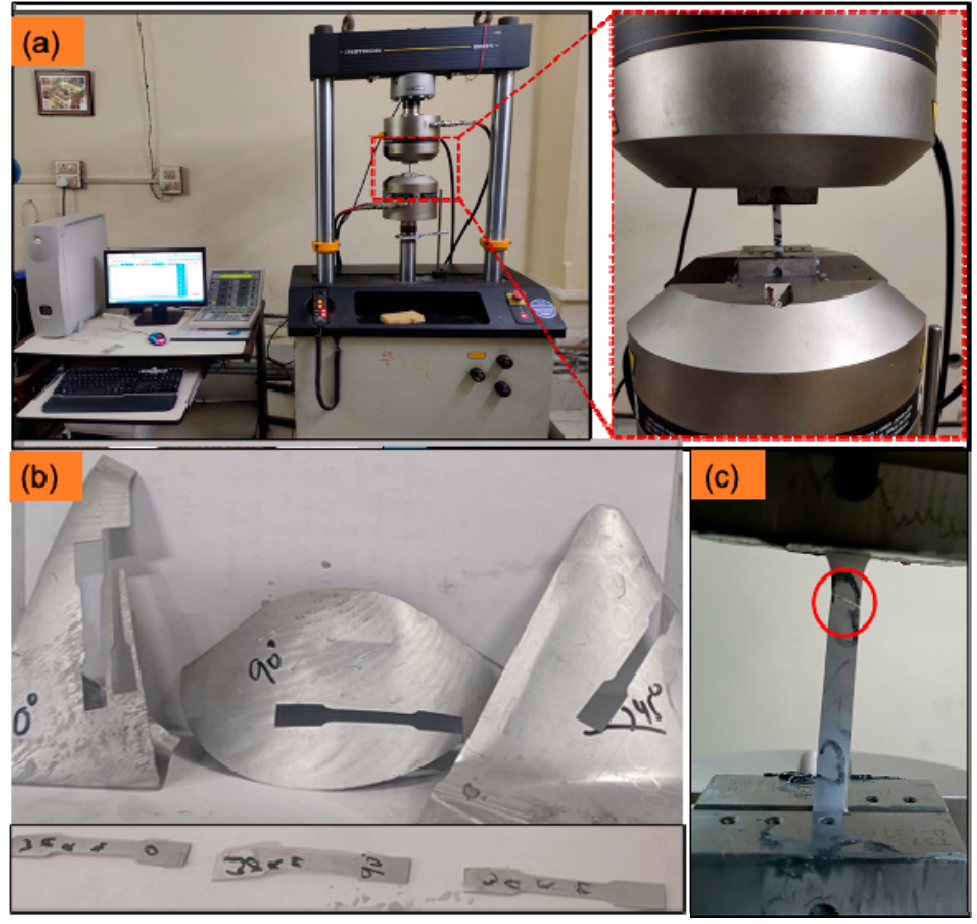
Figure 14. ( a ) UTM setup for tensile testing with mounted sample; ( b ) slots made after cutting of tensile samples in three directions: along the length of cone in the direction of tool (circumferential direction), and in the direction of 45° to the tool direction along the surface of the cone and respective samples after cutting; ( c ) fractured tensile tested samples marked in red circle. Engineering tensile stress–strain curves and true-stress–true-strain curves of samples are shown in Figure 15. The true stress is shown until UTS in all cases.